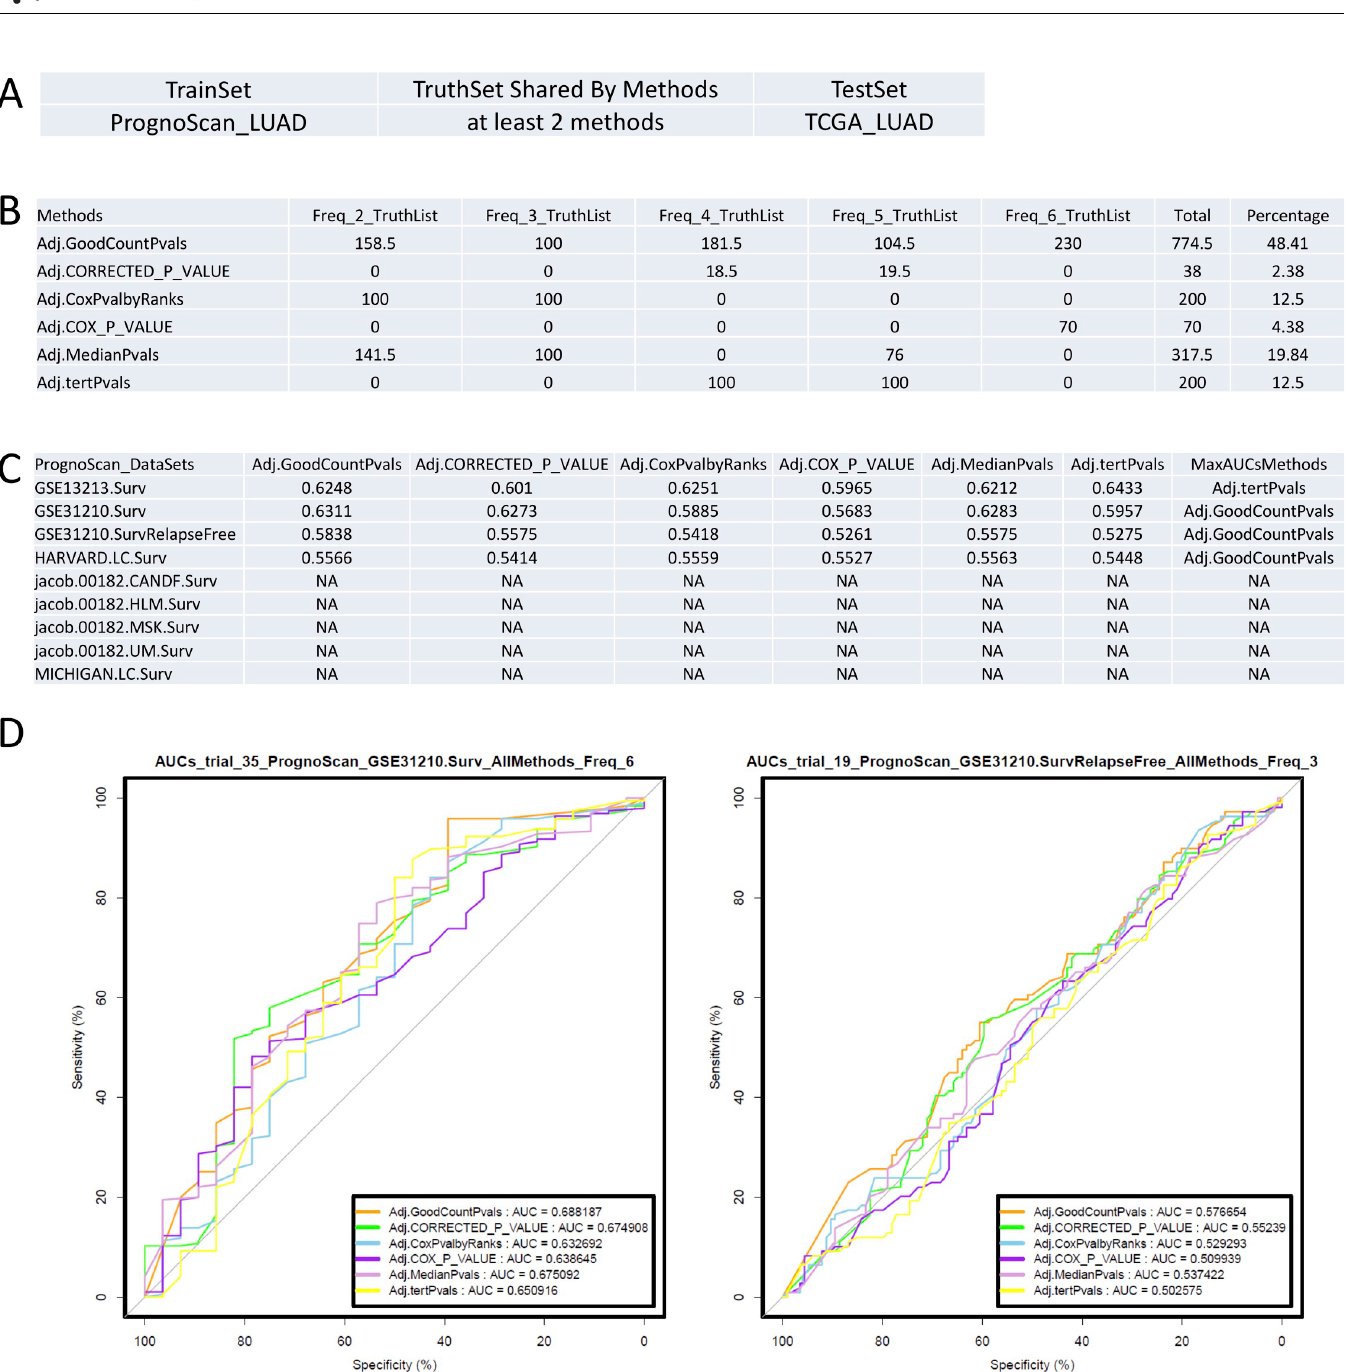
Fig 4. Performance comparison with ROC analysis by shared truth lists. (A). ROC analysis comparing all listed methods for the same set of truth gene lists that were shared amongst multiple truth lists derived from individual methods using PrognoScan LUAD data as the Training Set and TCGA LUAD data as the Testing Set. The settings table shows which datasets were used for the Training Sets and Testing Sets, as well as whether the Truth Set of genes derived from training are shared lists from at least 2 listed methods. The general ROC analysis procedure was described in the Materials and methods section. (B). Performance comparison table listing numbers of times/trials that a method has the largest AUC of ROC curves compared to other methods for the same set of truth gene lists (shared by at least 2 listed methods) and same trial of Testing Set dataset. All truth lists from Training Sets and the result lists derived from Testing Sets are at the adjusted p-value < = 0.05 for each method. The Freq_2_TruthList consists of the truth gene list shared by at least 2 of these selected methods; Freq_3_TruthList consists of the truth gene list shared by at least 3 of the selected methods etc.. Column “Total” summarizes the total counts for all scenarios (if a tie, each method would get 0.5 counts). Percentage lists the proportions of those counts. The details of each trial are shown in Table C in S1 File . (C). Average AUCs of ROC analysis for each method in each subset of total trials of data defined by 100 trials of TCGA data combined with one of the indicated PrognoScan datasets in column “PrognoScan_Datasets” (also see Materials and methods section for details). The last column”MaxAUCsMethods” shows the method with the maximal AUC for each row. (D). Examples of ROC plots showing AUCs of GradientScanSurv method are the largest in these trials.